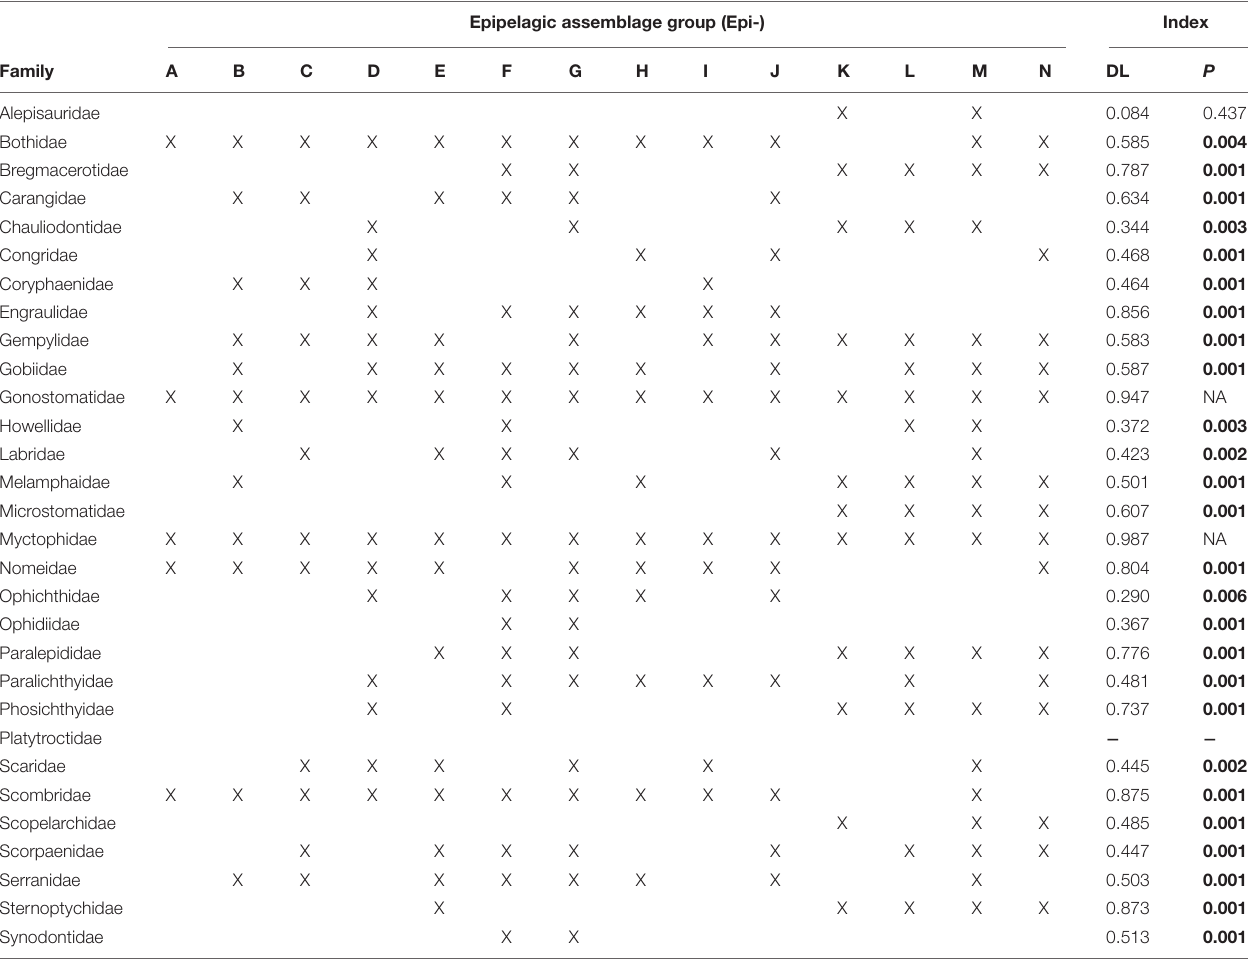
TABLE 2 | Dufrêne-Legendre (DL) indicator values characterizing the association of larval fish families with epipelagic assemblage groups (or combinations of assemblage groups) following De Cáceres et al. (2010). Epipelagic assemblage group